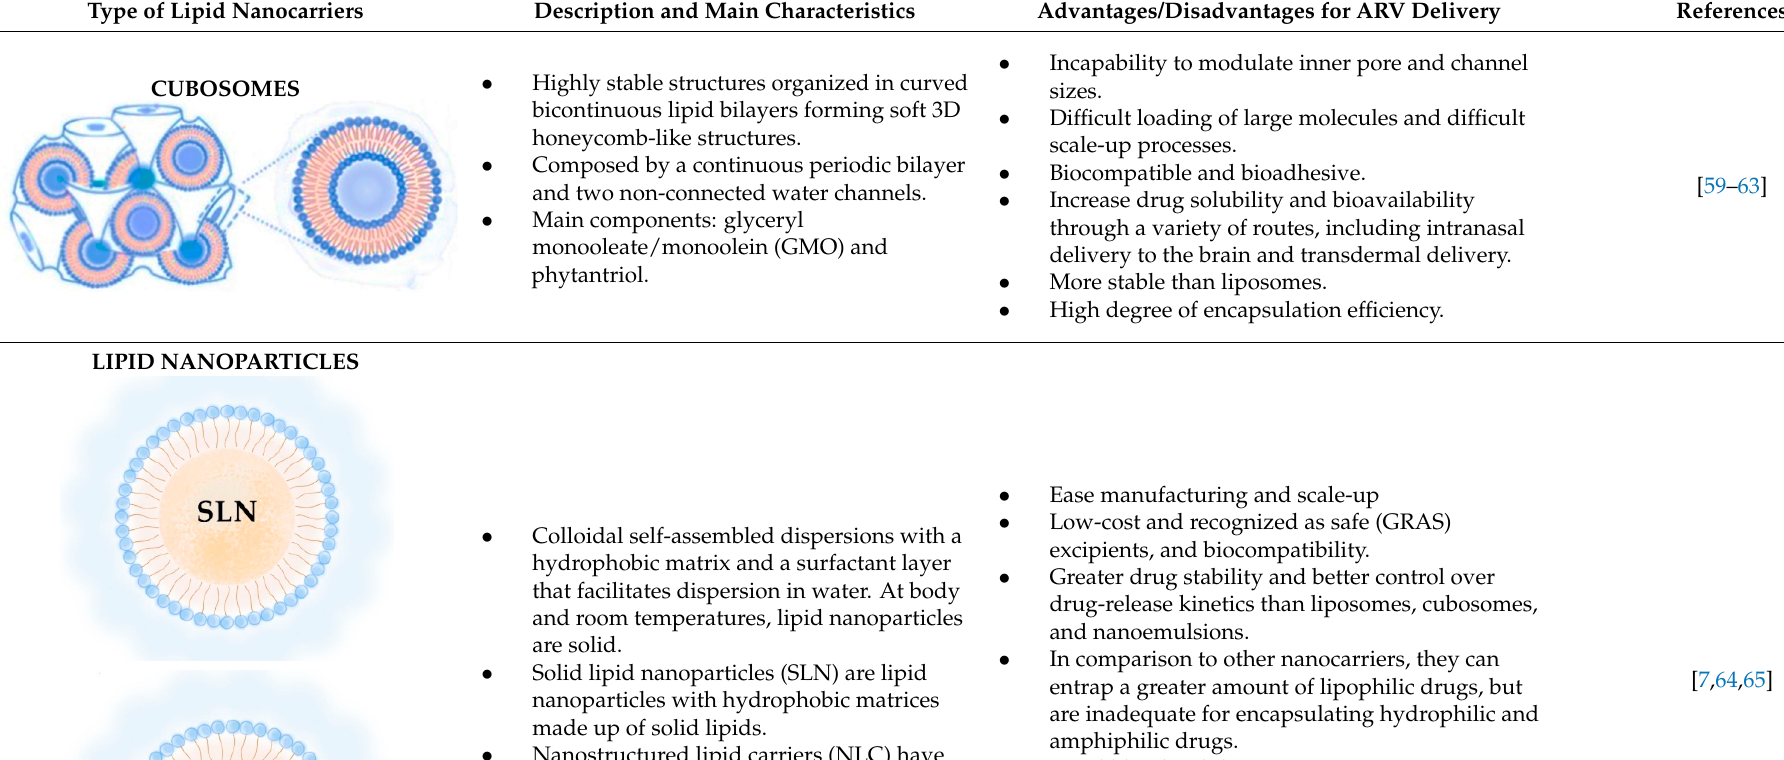
temperatures, lipid nanoparticles are solid.  Solid lipid nanoparticles (SLN) are lipid nanopar ‐ ticles with hydrophobic matrices made up of solid